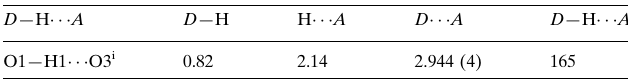
Hydrogen-bond geometry (A˚ , (cid:4)